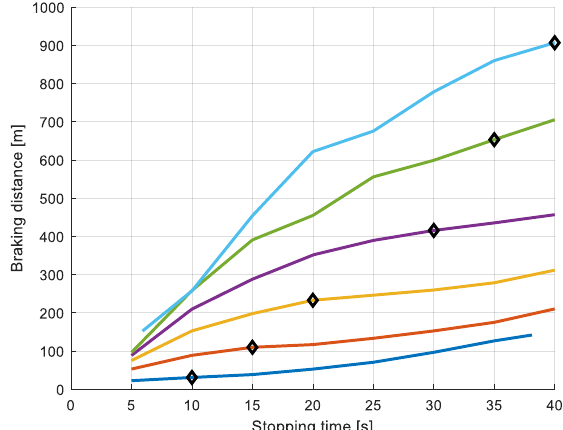
Figure 14. Recovered energy fraction versus stopping time at various starting speeds.